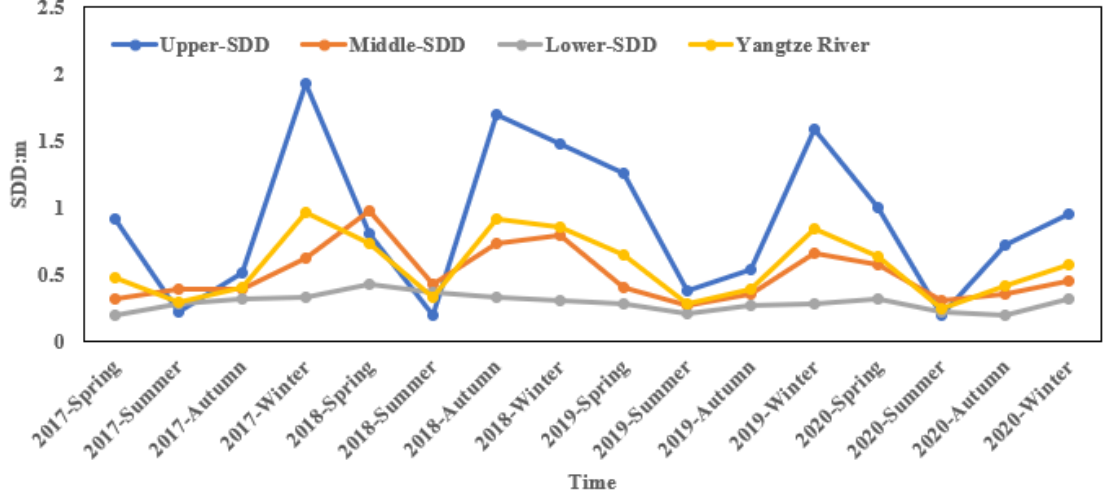
Figure 8. The results of inter-annual variation of upper reaches, middle reaches, and lower reaches of the Yangtze River. Table 2. The annual mean value results of upper reaches, middle reaches, lower reaches of the Yangtze River SDD.